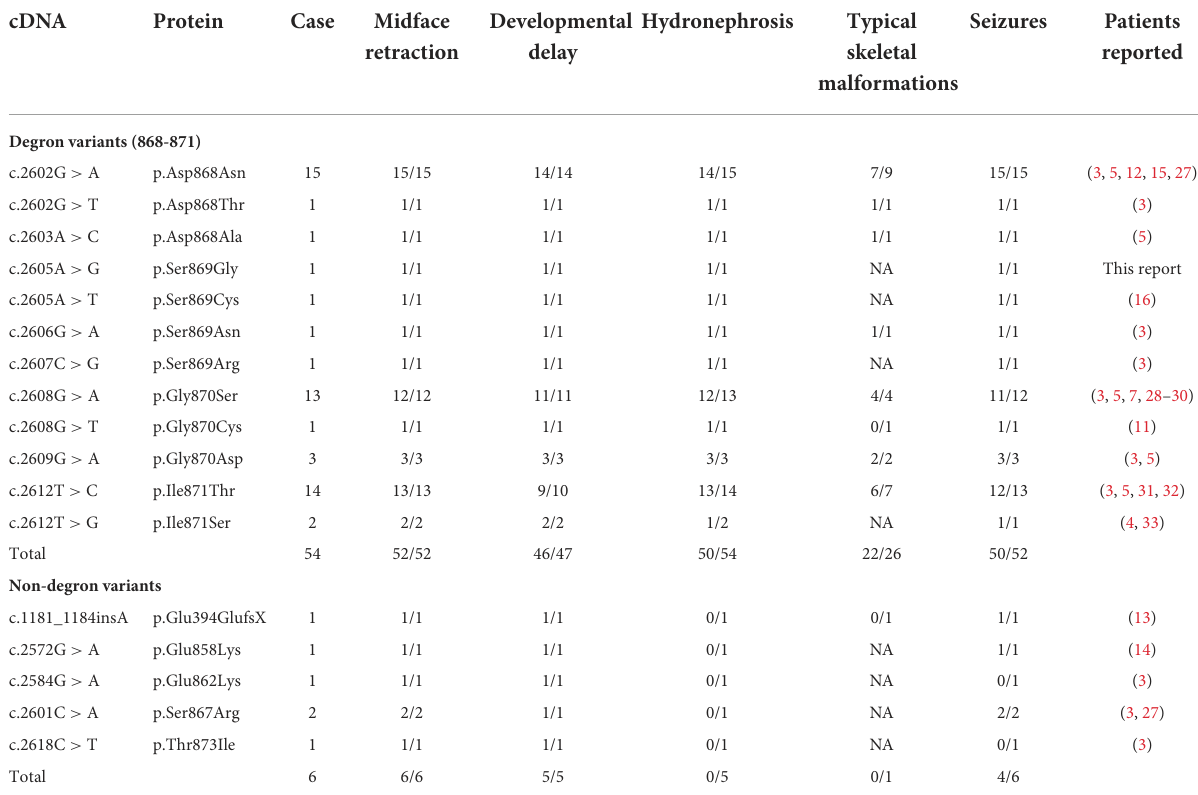
TABLE 1 SETBP1 variants and the main clinical features of 60 patients clinically diagnosed with SGS. cDNA Protein Case Midface